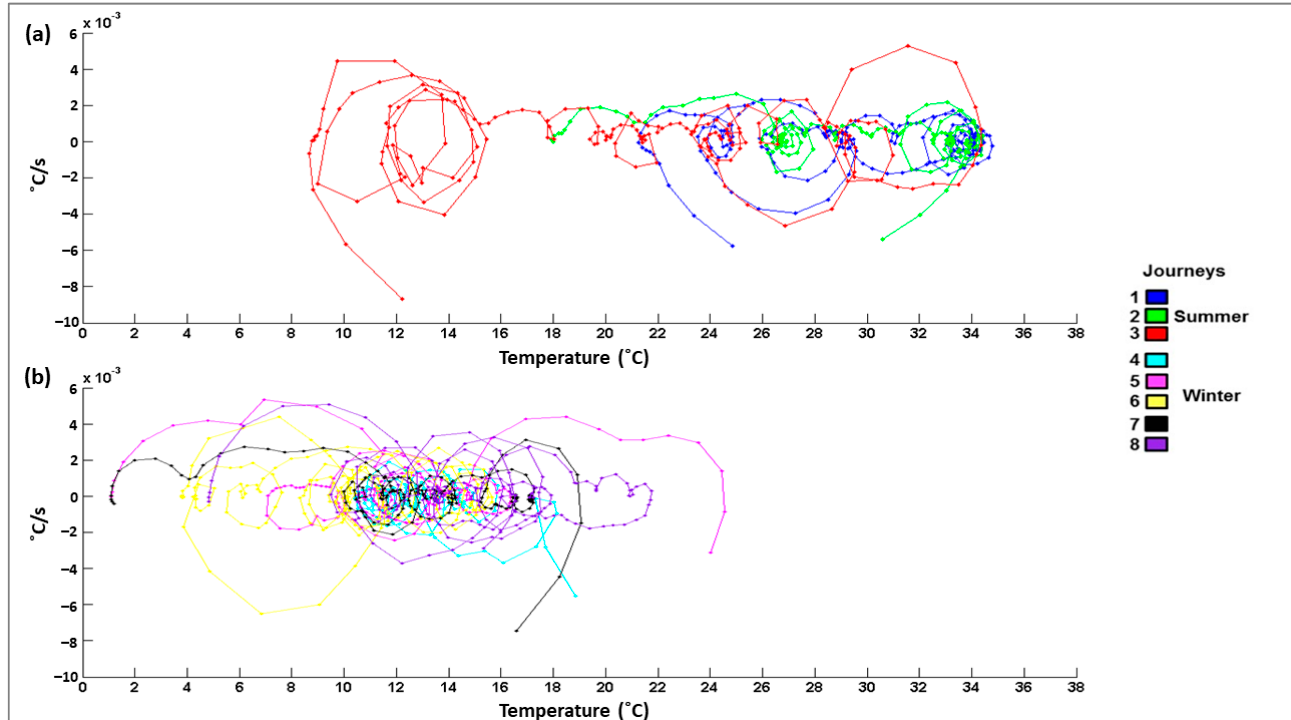
Figure 3. Speed of change or gradient in temperature (°C/s) inside the livestock vehicle during transport from Spain to Portugal in ( a ) summer and ( b ) winter plotted against the average temperatures (°C).